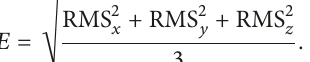
achieve a local maximum at cavitation number 𝜎 =